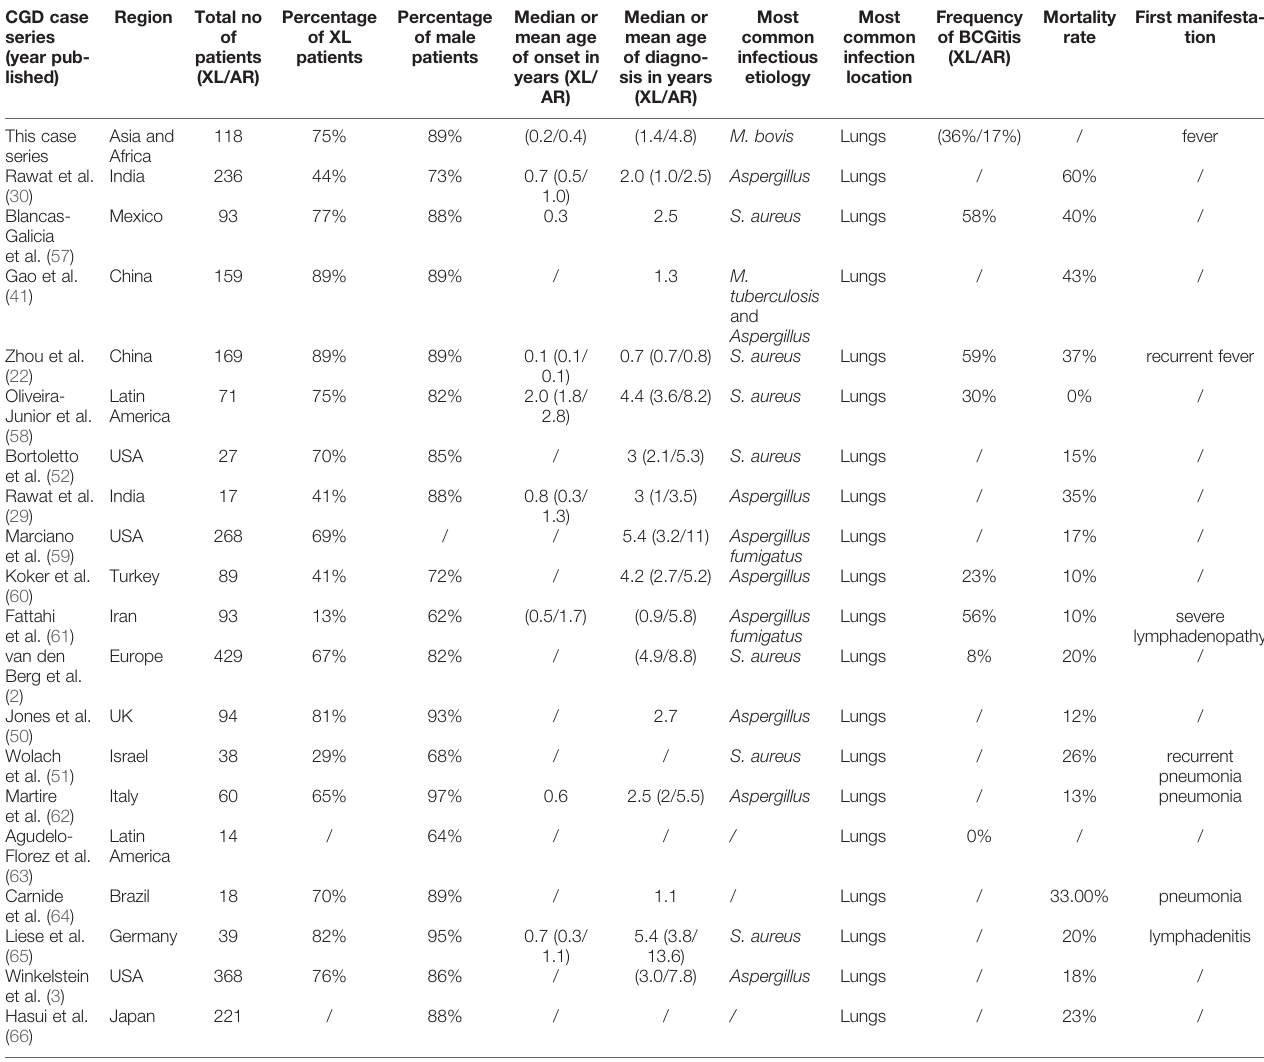
TABLE 3 | A summary of fi ndings regarding the differences between previous case series and this case